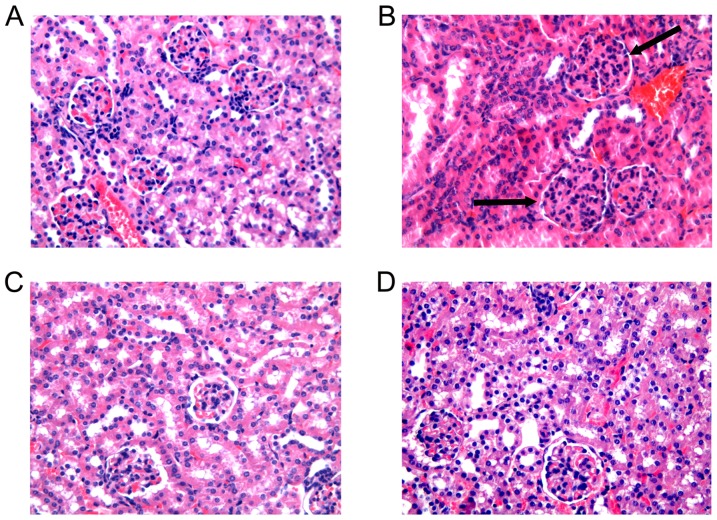
Kidney pathology.The kidney sections were stained with hematoxylin and eosin (H&E) and representative images are shown. (A): Normal glomerulus from a normal control mouse (n = 10). (B): Proliferative glomerular lesions and mononuclear cell infiltration in glomerulus from a model control mouse (n  =  10). (C): A marked reduction in pathological lesions in glomerulus from a mouse from the resveratrol A group (n  =  10) (D): A marked reduction in pathological lesions is observed in glomerulus from a representative resveratrol B mouse (n  =  10). (original magnification×200)